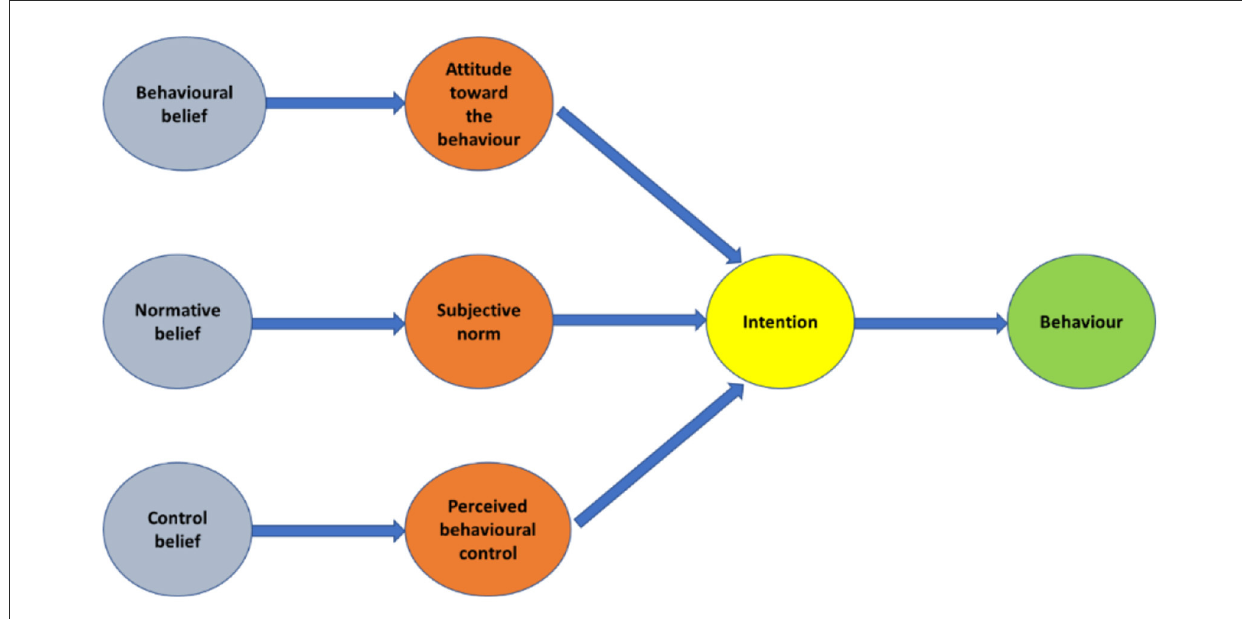
FIGURE1 Theory of planned behavior*. *Our elaboration.